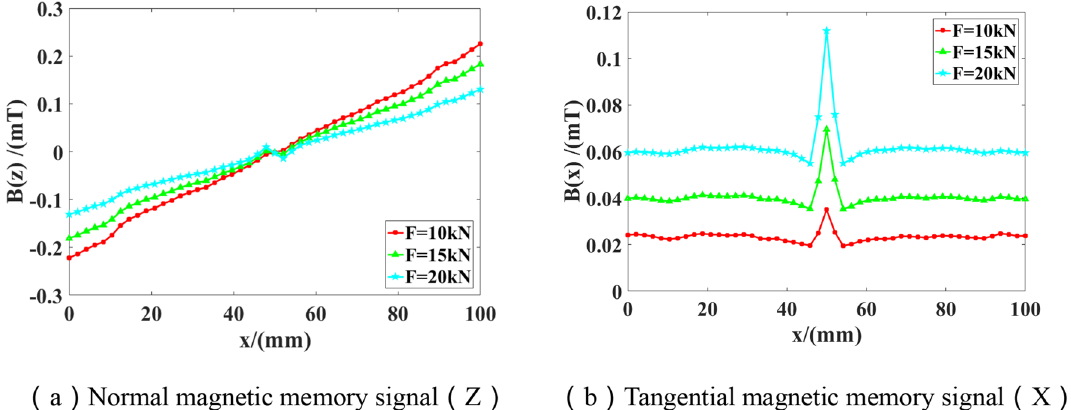
Fig. 8 Magnetic memory signal changes in the excitation field under different tensile forces of longitudinal cracks. a Normal magnetic memory signal (Z). b Tangential magnetic memory signal (X)